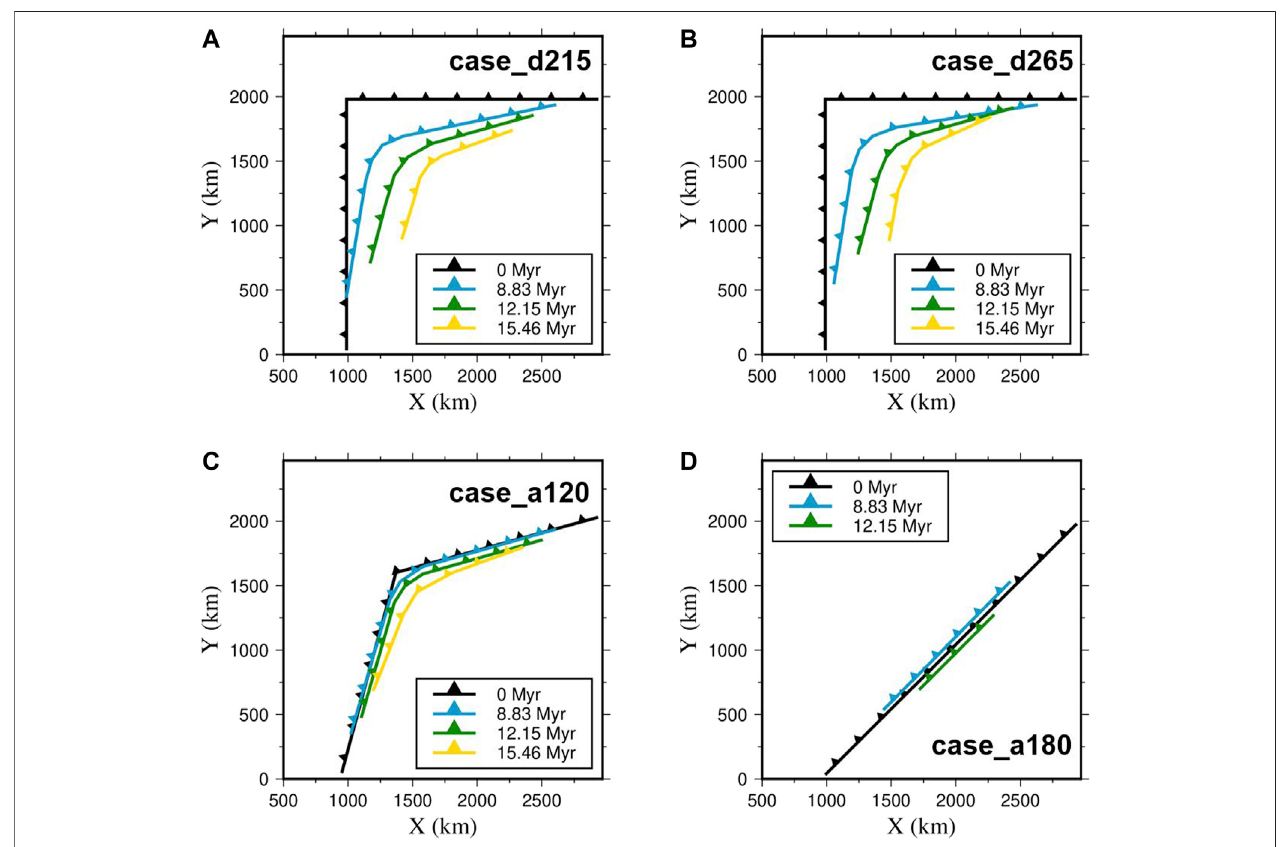
FIGURE 8 | Trench migration history in case_d215 (A) , case_d265 (B) , case_a120 (C) , and case_a180 (D) .